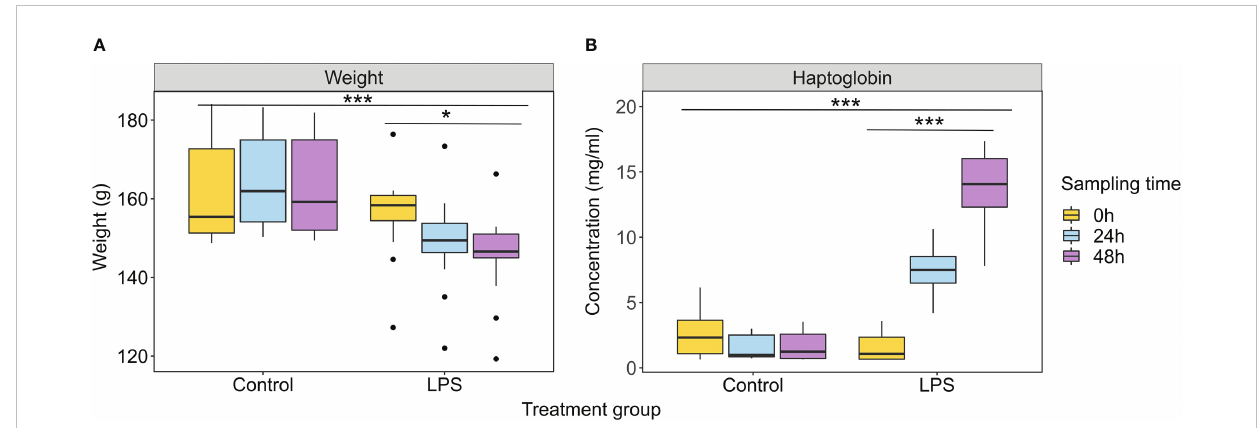
FIGURE 1 Physiological responses of bats from the control and treatment (LPS) groups during three sampling times. (A) Body weight. (B) Haptoglobin concentration. Results are presented as mean ± SEM. * p <0.05, *** p <0.001. For full ART ANOVA statistics see Table